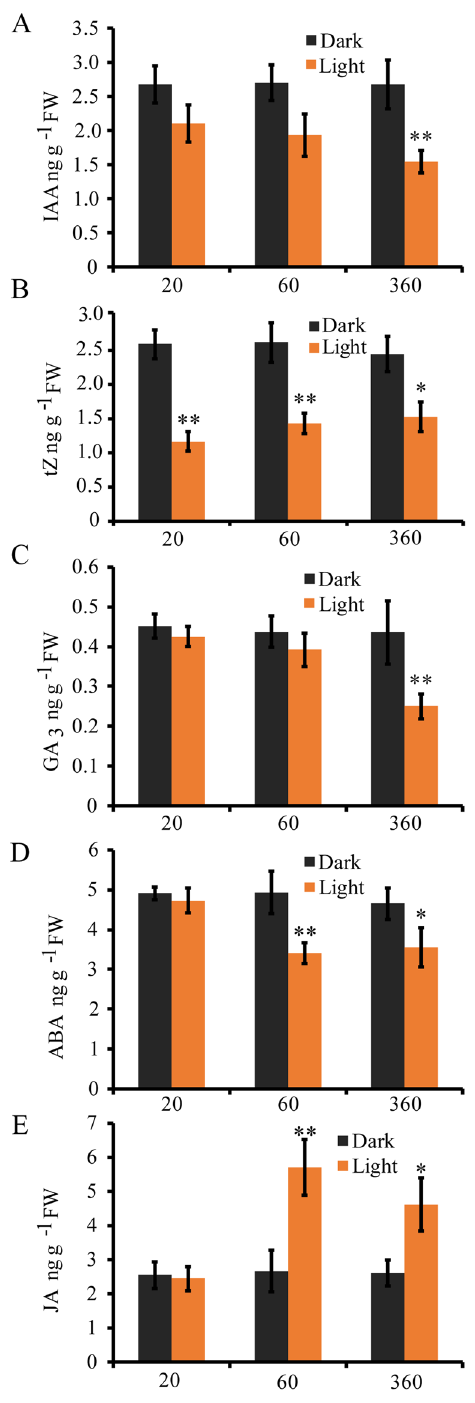
Figure 6. The phytohormone levels in the mesocotyl of the seedlings. The levels of IAA ( A ), tZ ( B ), GA 3 ( C ), ABA ( D ) and JA ( E ) in 3-day-old seedlings raised in complete darkness and irradiated with white light for 20, 60 and 360 minutes. The results represent the average of three biological replicates. The asterisks indicate significant difference compared with control value ( ** P < 0.01; * P < 0.05, Student’s t